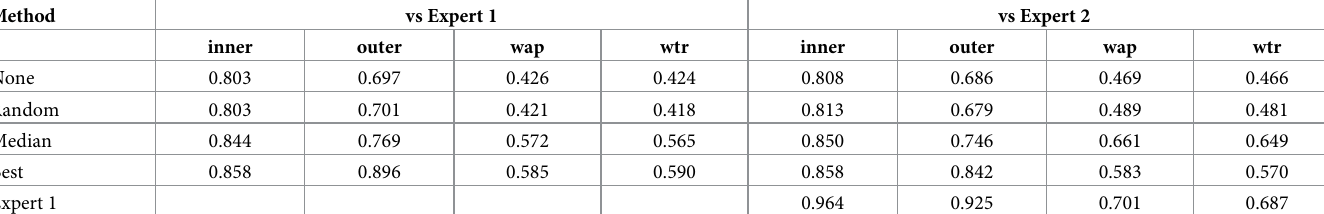
Table 2. Pearson correlations between the expert and the crowd with different combining methods, and between two experts.